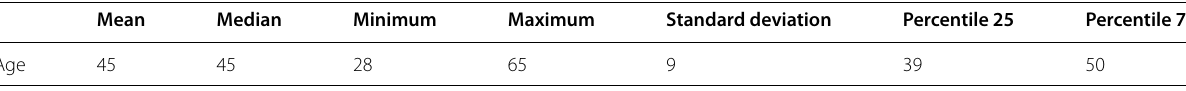
Table 1 Age distribution among the studied patients